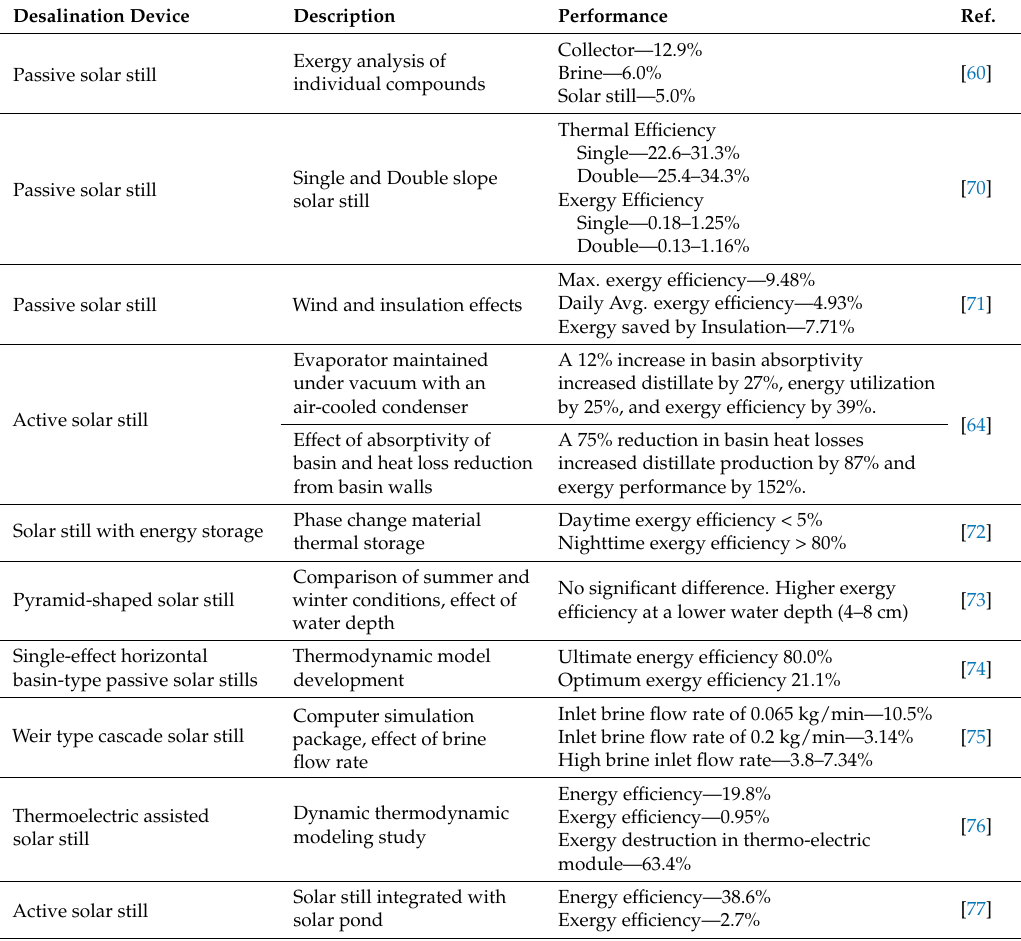
Table 7. Exergy efficiency in solar